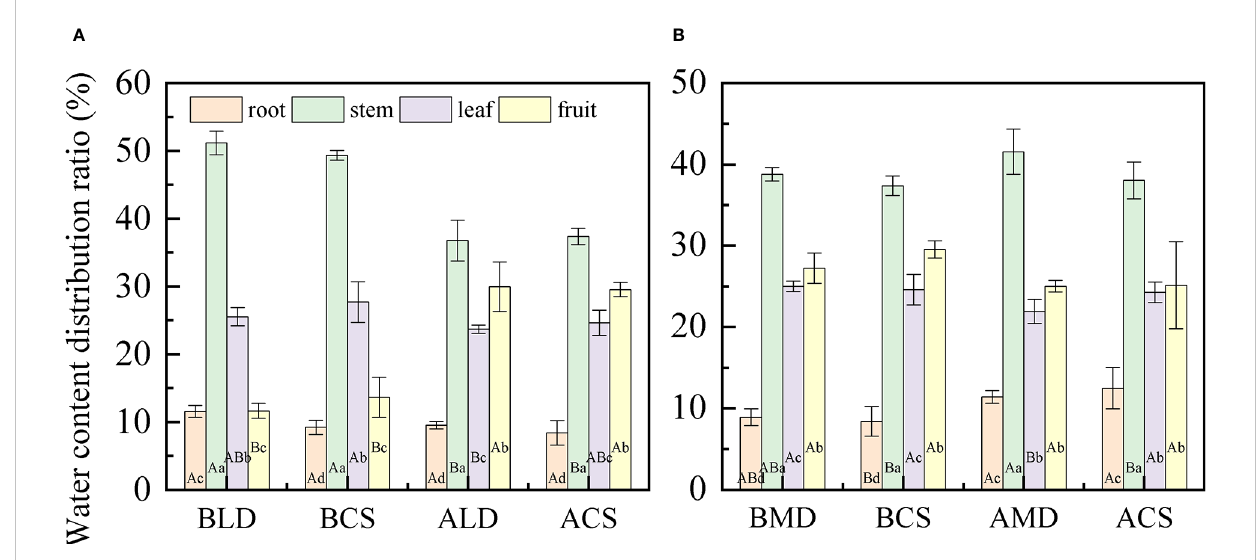
FIGURE 4 Comparative analysis of the WCDR of component organs in different drought and after rehydration. (A, B) are comparative analysis of the WCDR of component organs in LD and MD, respectively. Error bars represent standard deviations (n = 3), different capital letters indicate signi fi cant difference between groups (p< 0.05), and different lowercase letters indicate signi fi cant difference between different organs in the same group (p< 0.05). Note: BLD, BCS, ALD, and ACS and BMD, BCS, AMD, and ACS have the same de fi nitionsas in Figure